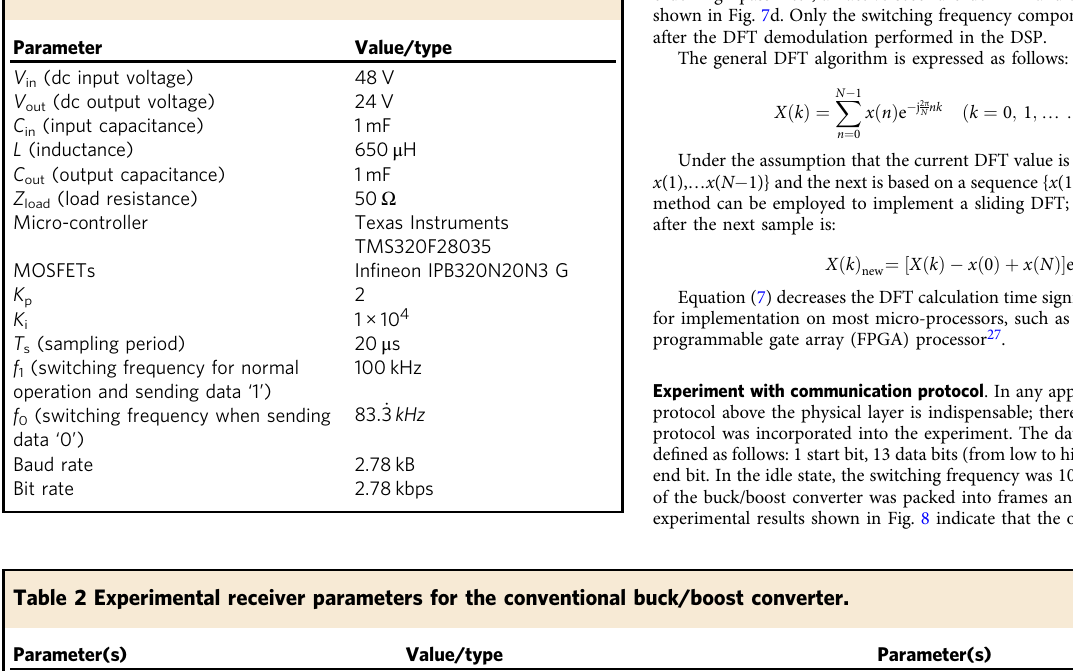
Table 1 Experimental parameters of the conventional buck/ boost converter.